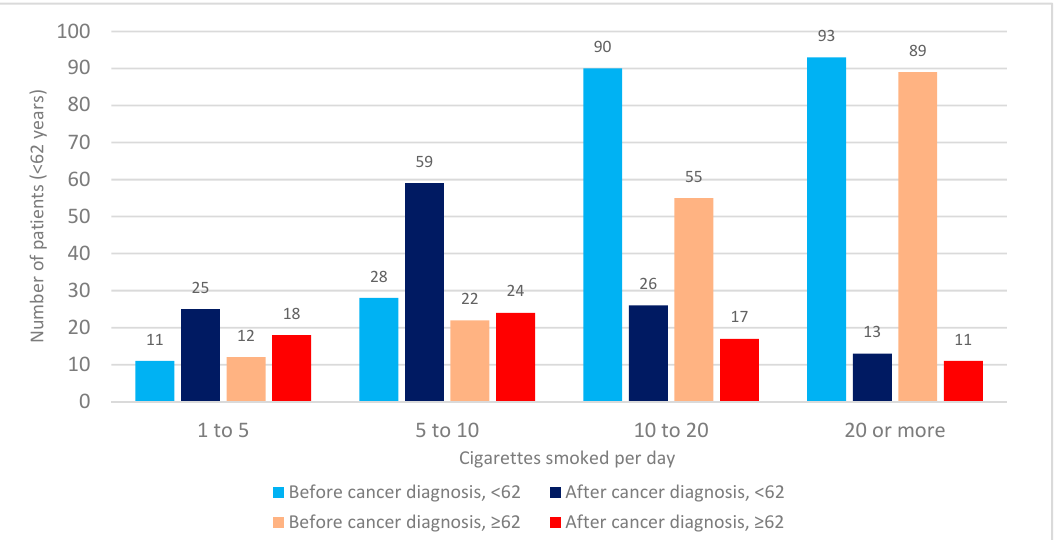
Figure 2. Analysis of the average number of cigarettes smoked per day based on median age at any time before cancer diagnosis and during the cancer treatment. The blue-colored columns indicate patients under the median age of 62, while the red-colored columns include patients older than 62 years. Statistical significance in number of cigarettes smoked is registered only after cancer diagnosis ( χ 2 = 17.085, p = 0.004; U = 20287.000, p =